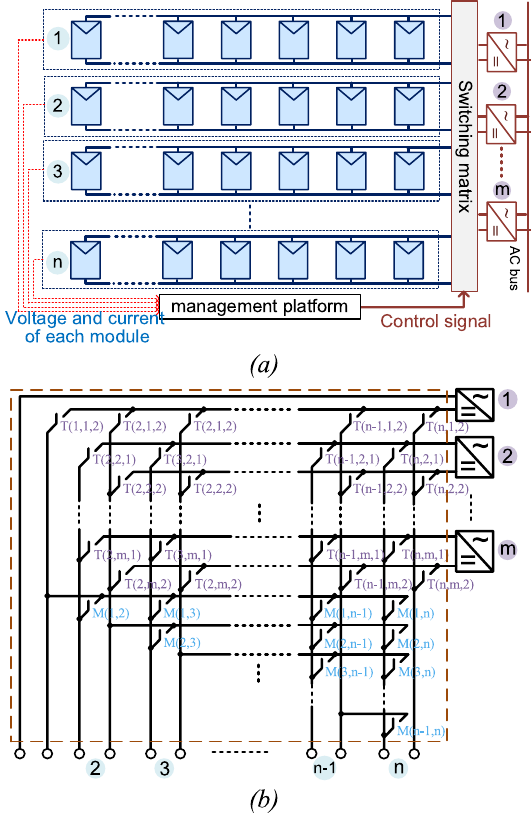
Fig. 4 The proposed method for the TCT-based PV array ( a ) Interconnection configuration; and ( b ) designed switching matrix